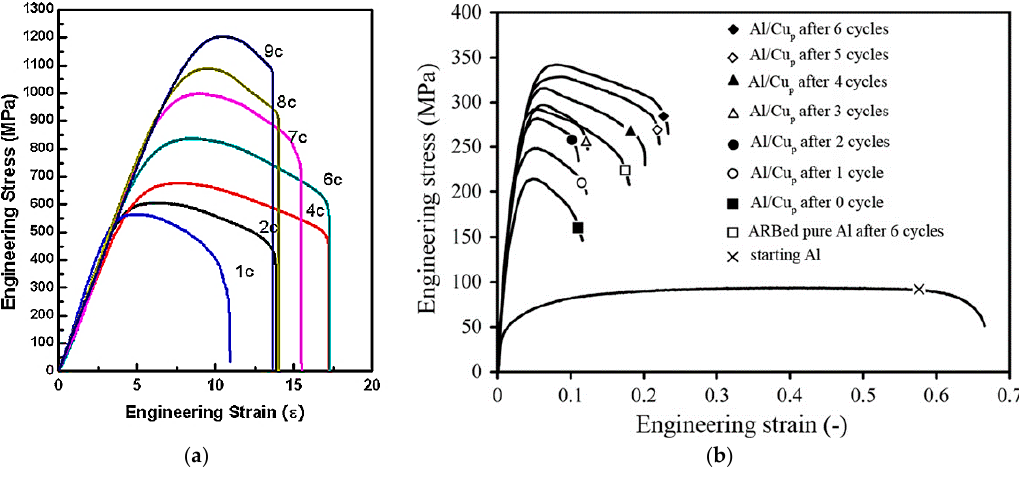
Figure 14. ( a ) Variation of stress–strain curves of the ARBed Cu/Zr materials versus ARB cycles; elongation increases up to six cycles [91], ( b ) engineering stress–strain curves for starting Al, ARBed pure Al after sixth cycle and Al/Cu p composite within different cycles of ARB process